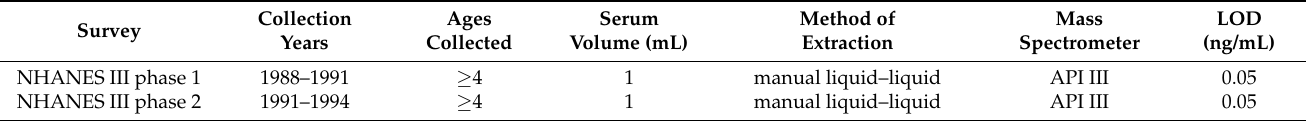
Table A1. Changes in NHANES study design including collection years, age of participants, volume of serum used for cotinine (COT) analysis, method of COT extraction, mass spectrometer model used for COT analysis, and serum COT limit of detection (LOD) by NHANES